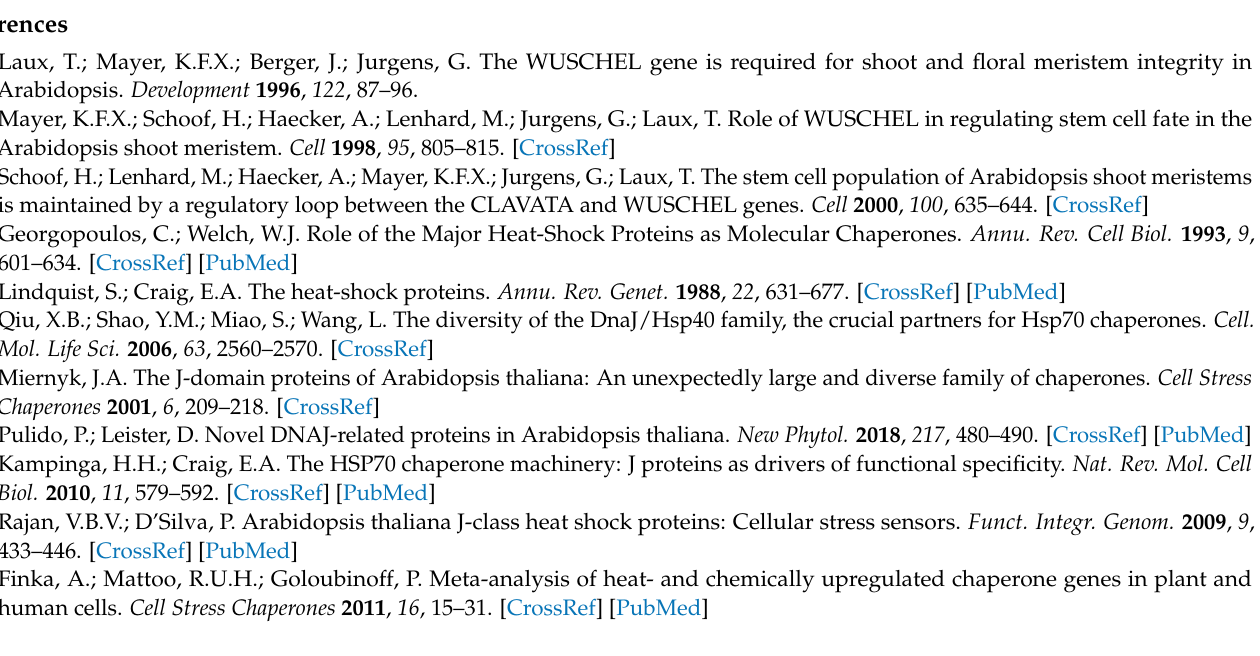
Table S1: The primers used in the